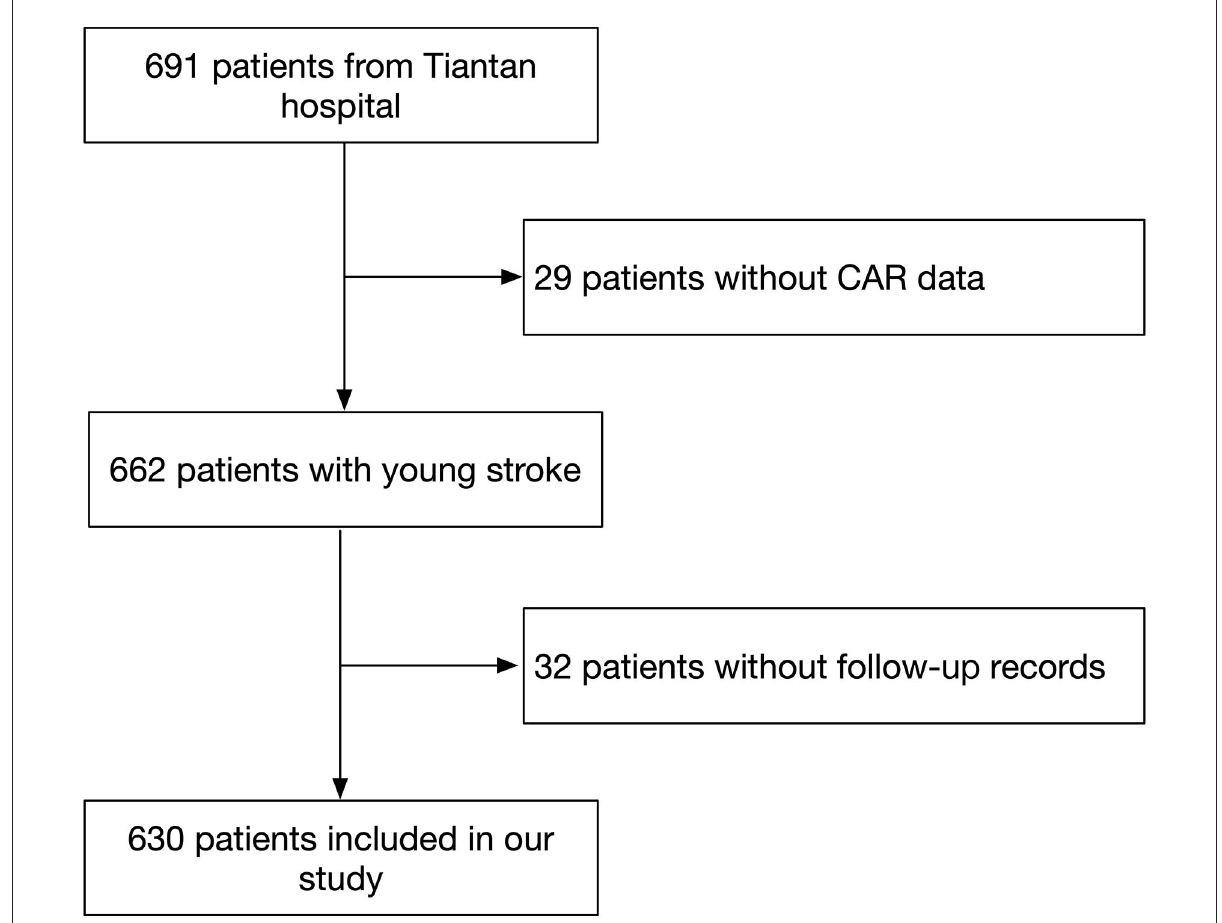
FIGURE1 Flow diagram of study patients. CAR indicates C-reactive protein to albumin